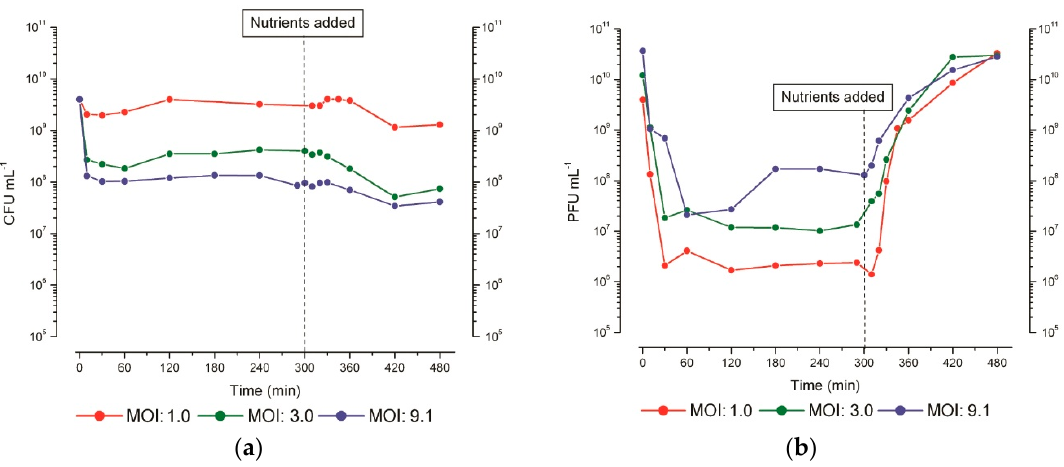
Figure 6. Stationary-phase phage production. Representative figures of ( a ) bacterial survivors (CFU) and ( b ) phage concentration (PFU) when T4 infection was carried out at three different multiplicities of infection (MOI) in parallel flasks split from the same 48 h-old culture of E. coli ZK126, with 0.12% w / v glucose and 0.1% w / v (CAA) re-added 5 h after infection. The addition could be delayed for at least 48 h. Figure reproduced from [27].